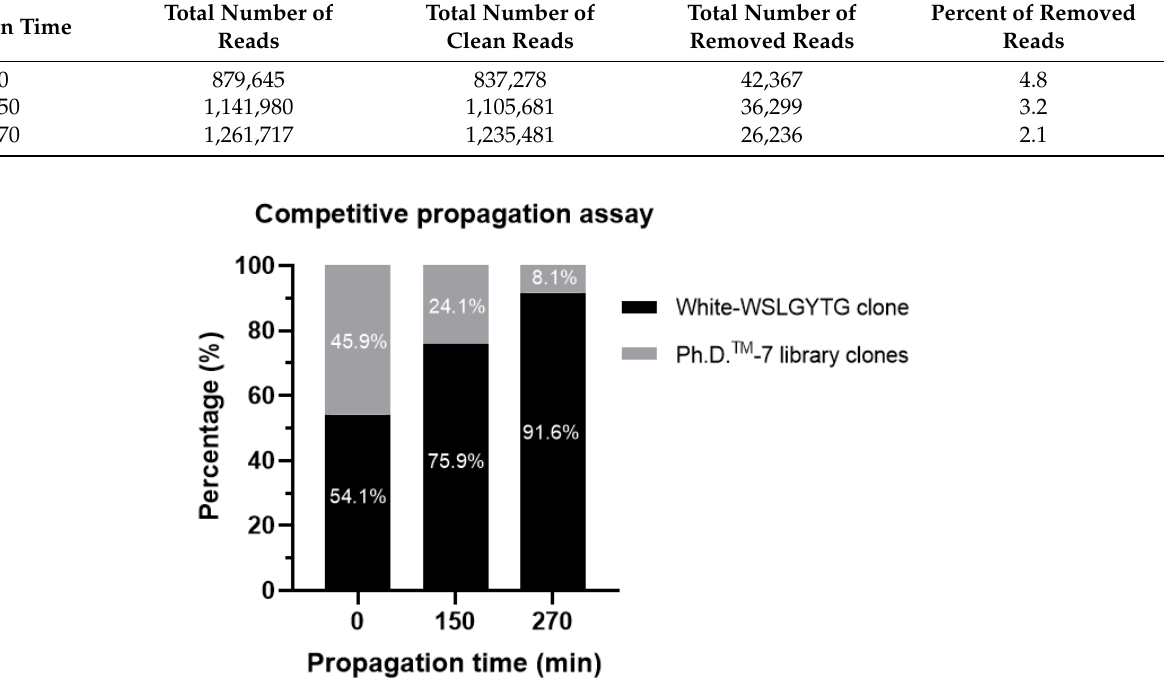
Figure 5. NGS-based competitive propagation assay. Equal titers of white-WSLGYTG clone and Ph.D. TM -7 library were inoculated in early log E.coli culture and amplified for 4.5 h. At three time points, samples were withdrawn and the percentage of WSLGYTG-displaying clone compared to random peptide library clones was calculated based on NGS data. A substantially higher propagation rate was found for WSLGYTG clone compared to the library (representing an average propagation rate of the clones in the library).